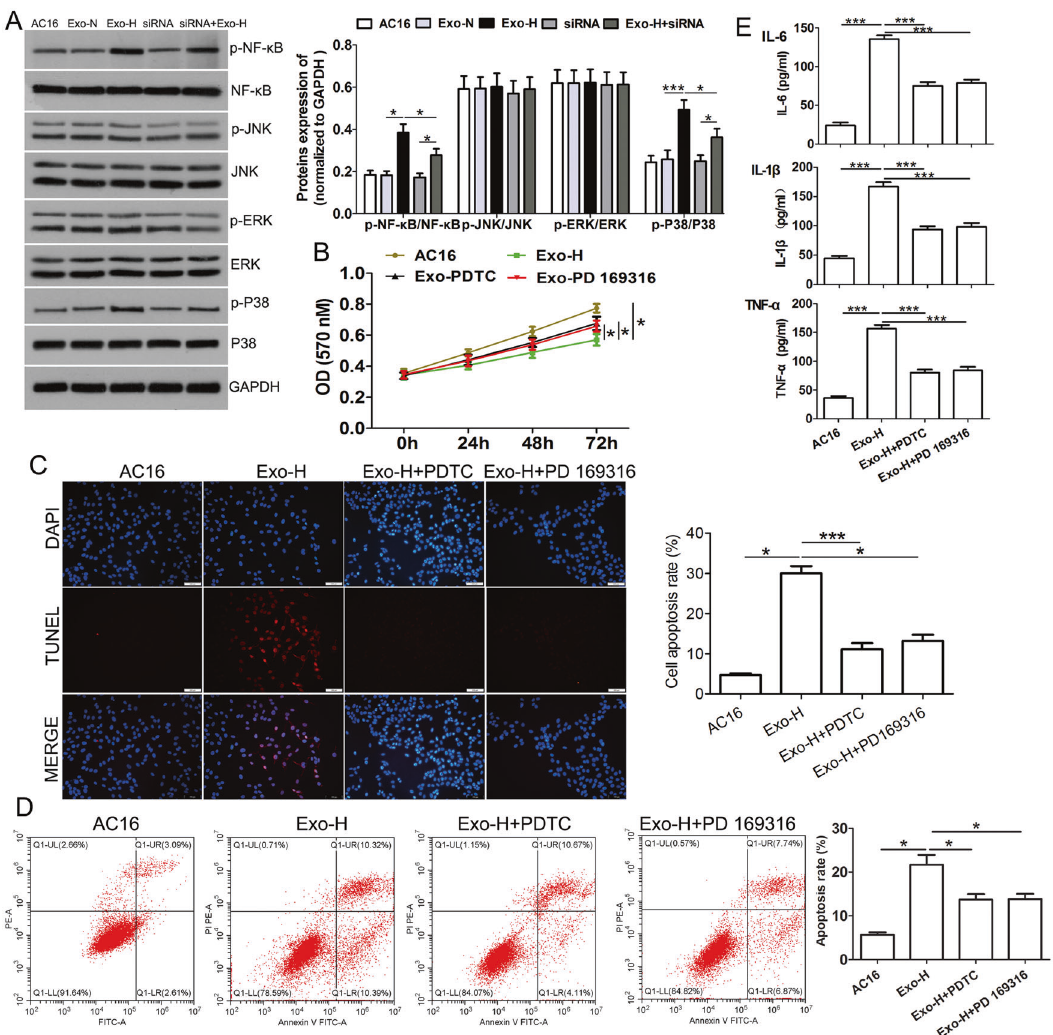
Fig. 5 Exosomal HCG15 released from hypoxic cells promoted cardiomyocyte apoptosis and the production of in fl ammatory cytokines via the NF- κ B/p65 and p38 pathways. A Western blotting was used to analyze the expression of NF- κ B/p65, JNK, ERK, and p38 signaling pathway molecules in AC16 cells after the indicated treatments. AC16 cells were incubated with Exo-H and subsequently treated with PDTC (0.1 mg/ml) or PD169316 (10 μ mol/l), and MTT assays ( B ) were used to detect cell proliferation. TUNEL staining ( C ) and fl ow cytometry ( D ) were performed to measure cell apoptosis, and the magni fi cation was 200 ×. E ELISA was used to measure the level of in fl ammatory cytokines. * p value < 0.05, *** p value < 0.001. Each assay was performed in